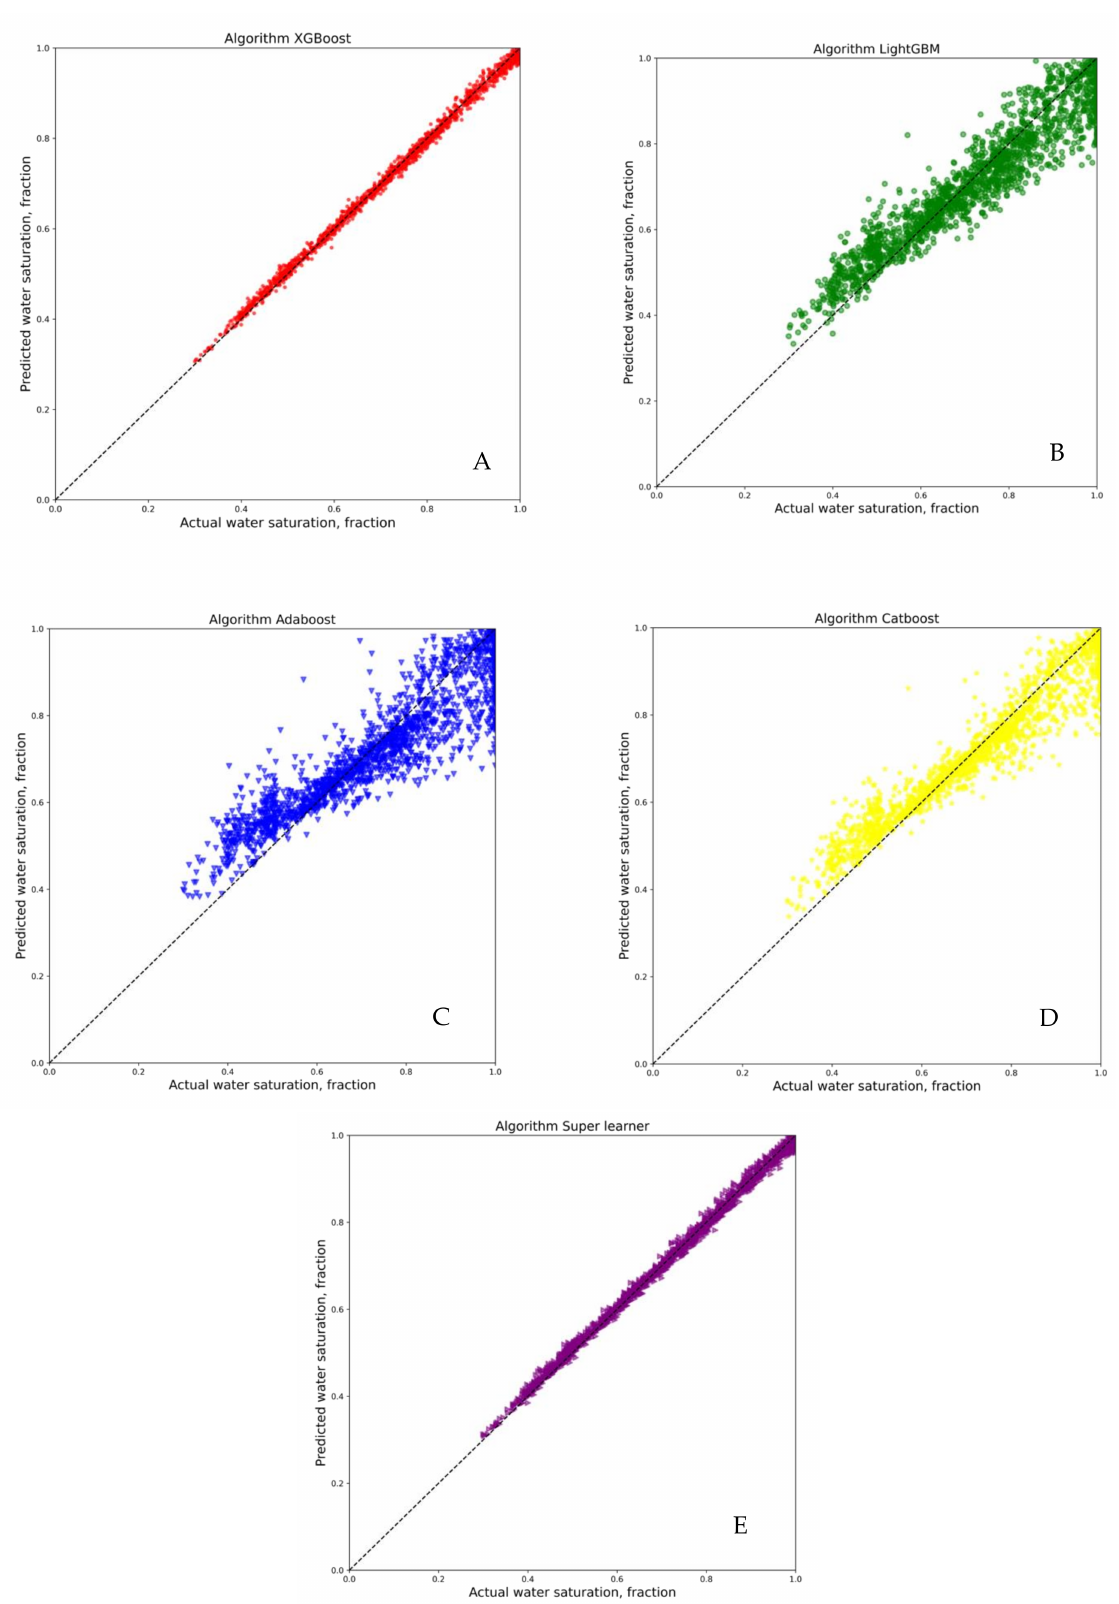
Figure 6. Cross-plot of water saturation prediction results by different algorithms for dataset A, which depicts well log data-lab verified values vs. algorithm based ones, ( A ) XGBoost, ( B ) LightGBM, ( C ) Adaboost, ( D ) Catboost and ( E ) Super